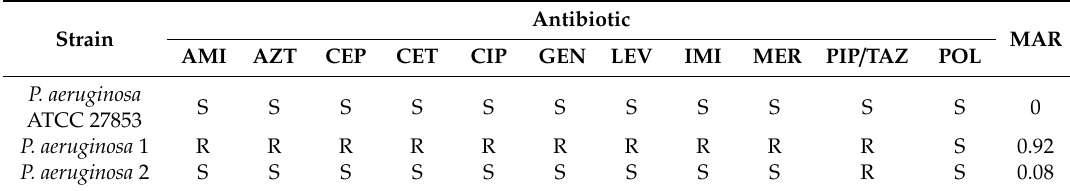
Table 1. Antibiotic susceptibility profile of P. aeruginosa